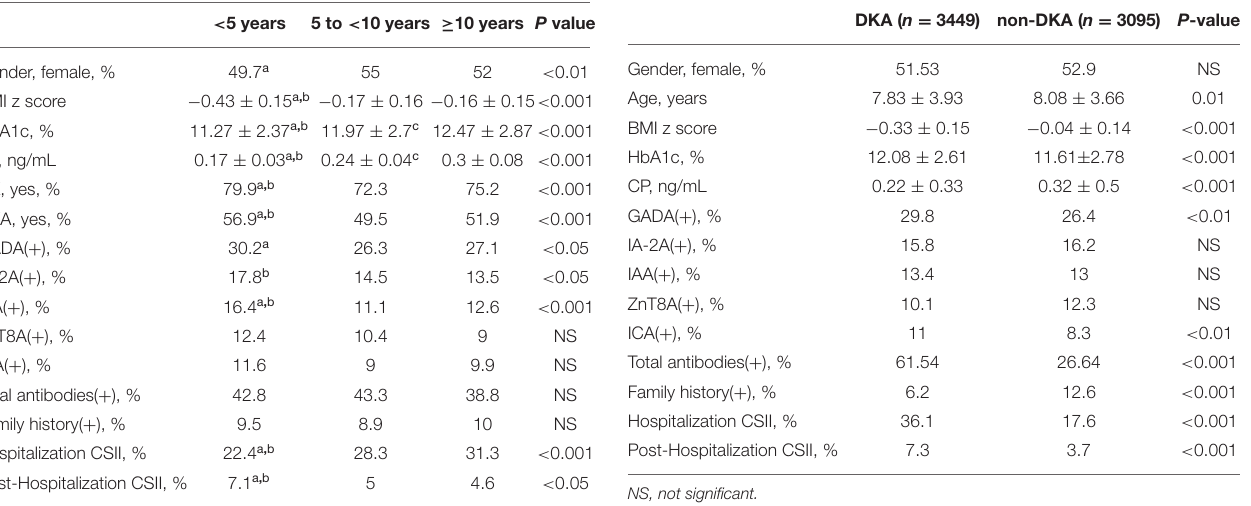
TABLE 3 | Participant characteristics and laboratory data comparing DKA and